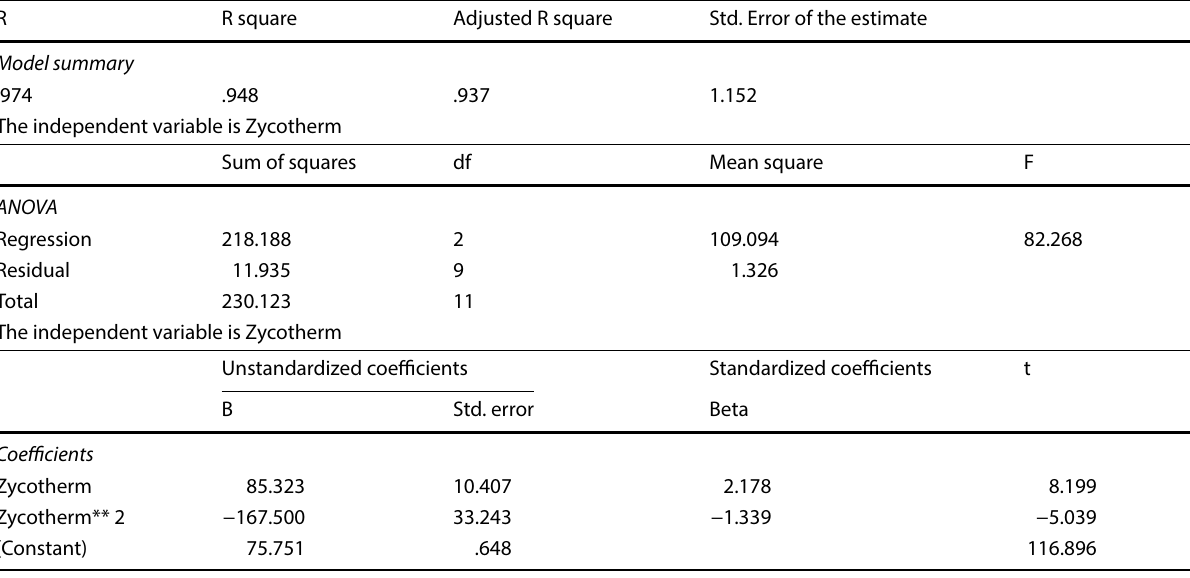
Table 4 Statistical analysis of TSR regression model—Water R R square Adjusted R square Std. Error of the